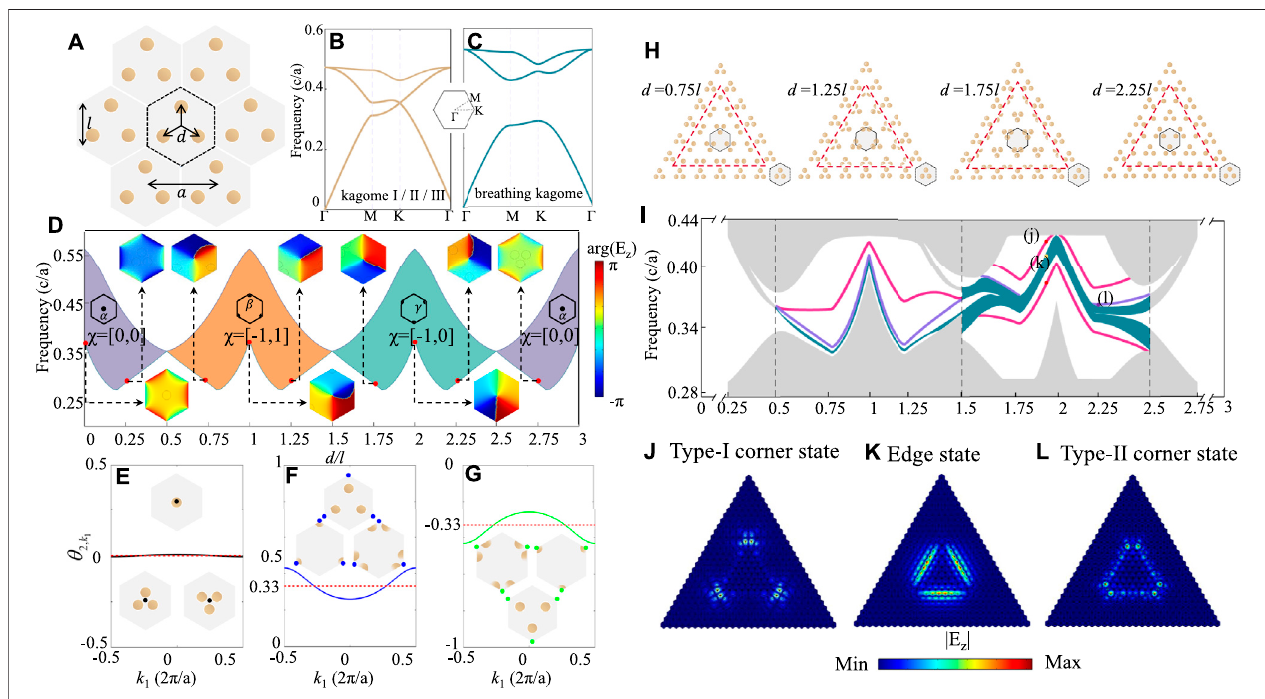
FIGURE 6 | Photonic higher order topological insulator [154]. (A) 2D PhCs with C 3 symmetry, where the primitive cell is indicated by hexagonal dotted lines. (B, C) Typical band structure for (B) triangular PhCs and (C) kagome lattice. (D) Eigenfrequencies of the fi rst and second photonic bands at the K point as a function of geometricparameter d .(E – G)ThecalculatedBerryphaseforPhCswith (E) thephase[0 , 0], (F) thephase[ − 1 , 1],and (G) thephase[ − 1 , 0].Thebulkpolarizationisshown in red dots. The corresponding Wannier center con fi guration is also displayed in the insets. (H) Schematic illustration of large triangular supercell with two types of PhCs with distinct higher order topology. (I) Eigenfrequencies of the photon as functions of the geometric parameter d . (J – L) Typical electric fi eld pattern for (J) type-I corner state, (K) edge state, and (L) type-II corner state. Reproduced permission from Ref. 154.